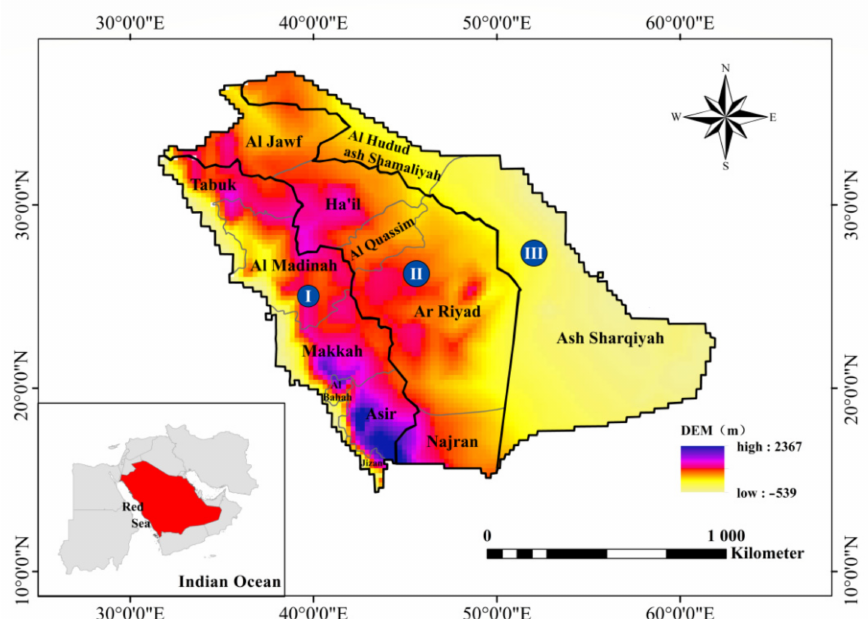
Figure 1. The geographic location of Saudi Arabia. The color variations represent the